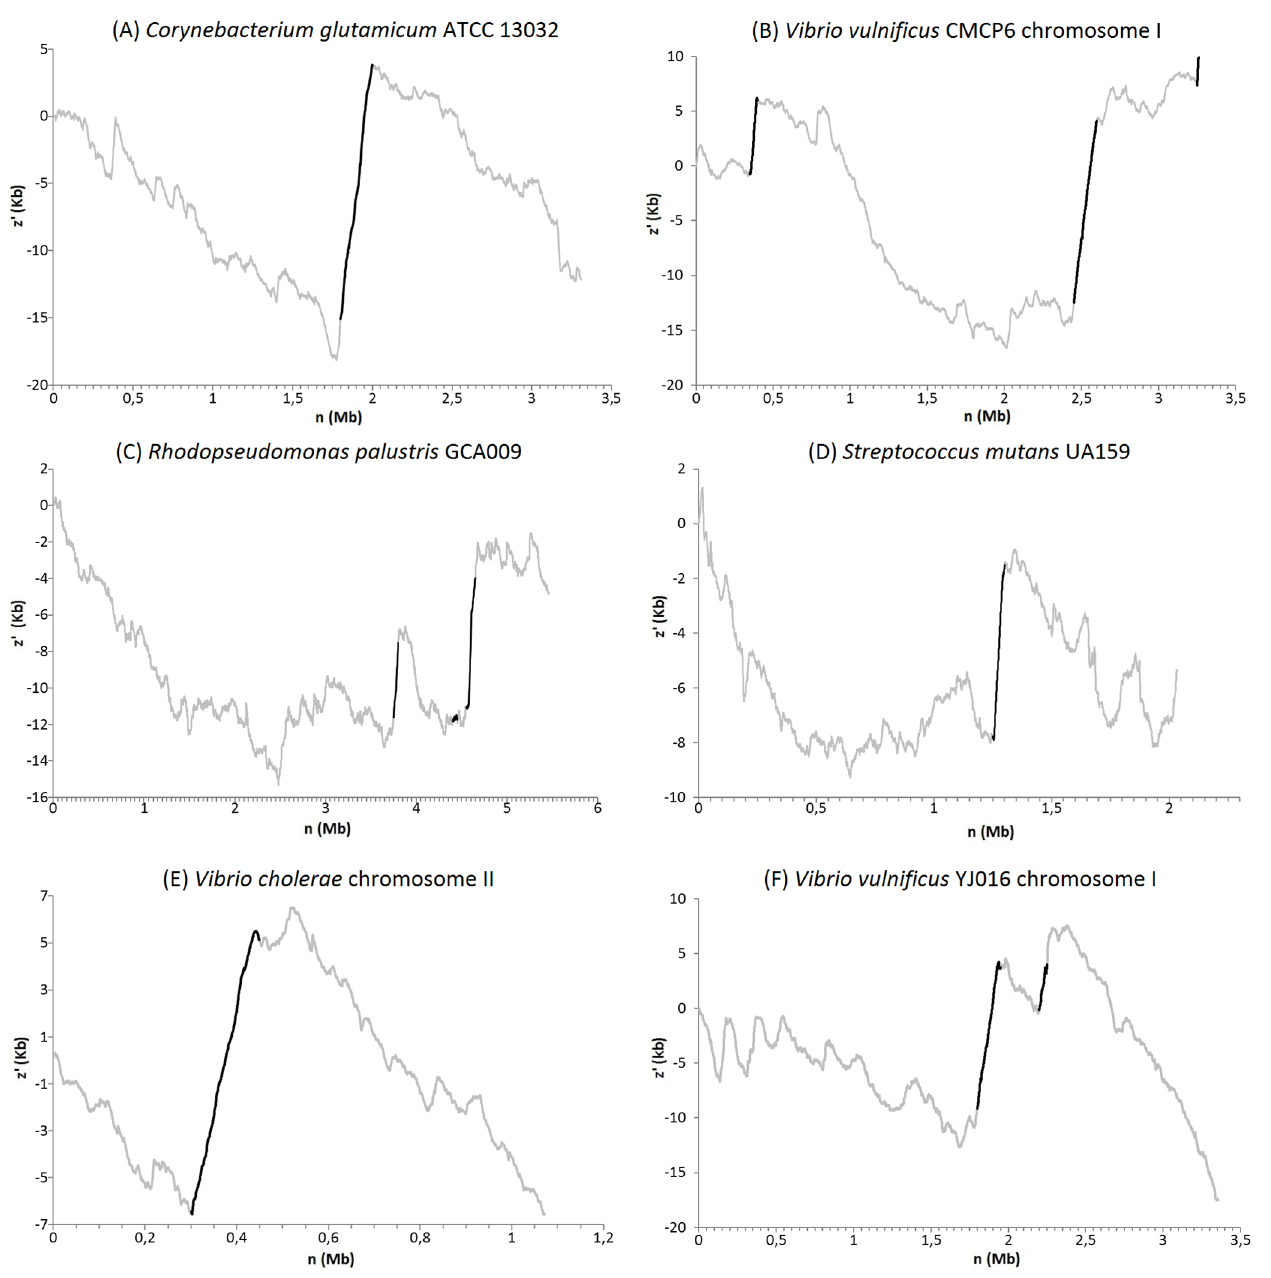
Fig 2. Graphics representing the z 0 curves for following six different bacteria genomes. (A) Corynebacterium glutamicum ATCC 13032, (B) Vibrio vulnificus CMCP6 chromosome I, (C) Rhodopseudomonas palustris CGA009, (D) Streptococcus mutans UA159, (E) Vibrio cholerae chromosome II e (F) Vibrio vulnificus YJ016 chromosome I. Black lines represents the genomic islands identified by the mean shift method.